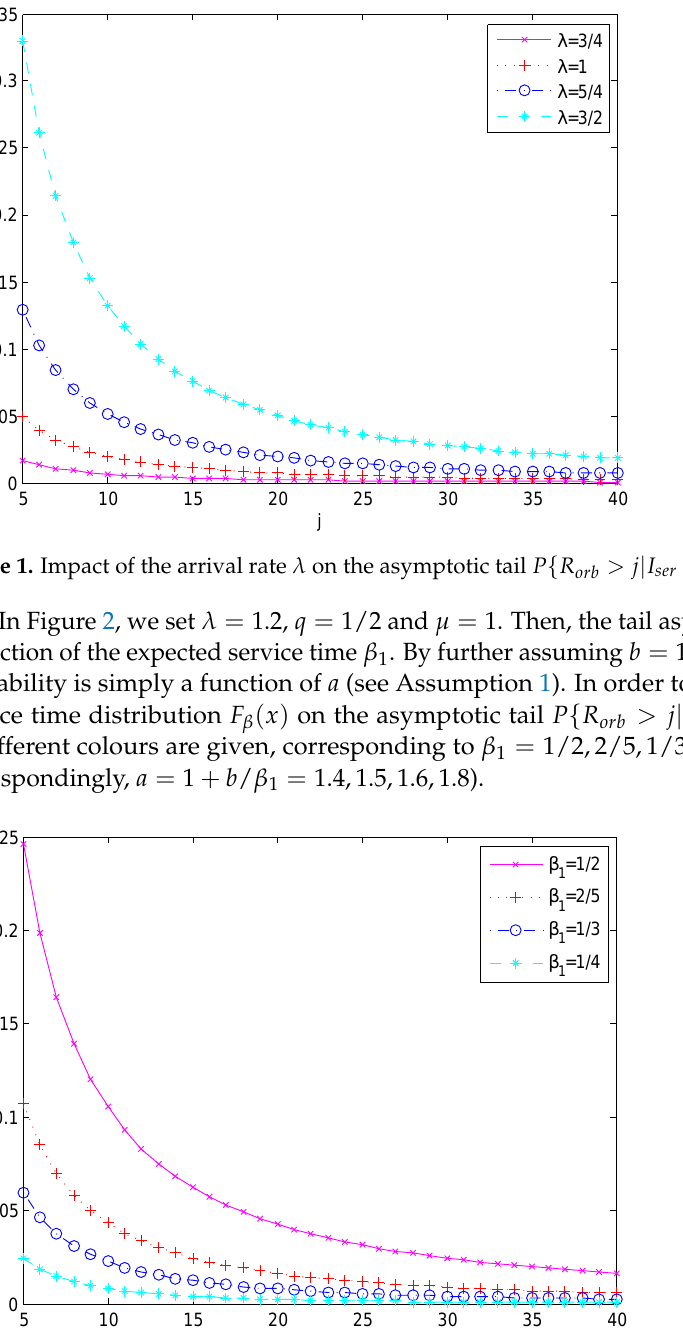
λ = 1.2 and q = 1/2. The four curves correspond to the following four different retrial rates: µ = 1/5, 2/5, 4/5, 8/5,